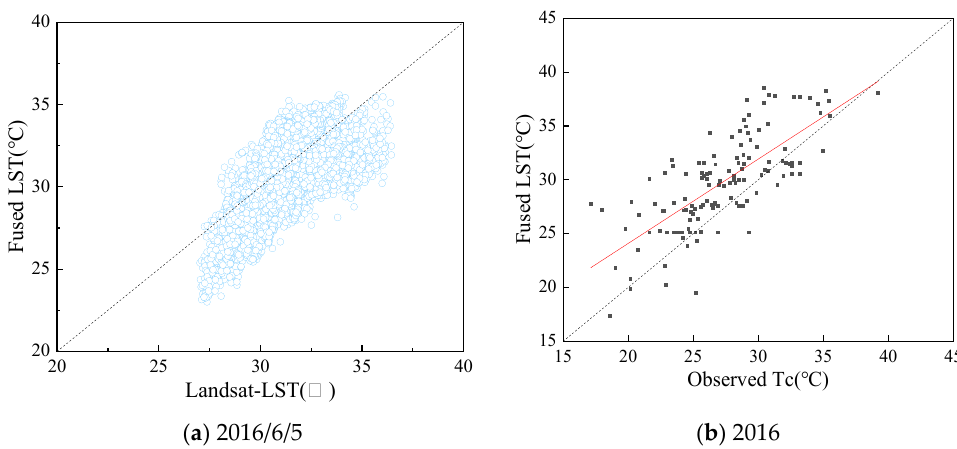
Figure 17. Regressions for accuracy evaluation of the fused LST: ( a ) the fused LST vs. the inversed values from Landsat 8; ( b ) the fused LST vs. the observed Tc in experimental station in 2016. Figure 18 shows the spatial grain yield estimates retrieved using DBA measured on four acquisition dates that include (a) 4 July, (b) 21 July, (c) 4 August, and (d) 26 August in 2016 based on the model calibrated in 2019. The predicted yield showed a significant upward trend as the acquisition date of DBA approached harvest. Meanwhile, the com- parisons between the predicted and measured yield in situ were conducted with statistical parameters as evaluation metrics of accuracy (Table 7). The predicted yields coincide with the measured ones with RE values, ranging from −16.14% to 9.84%, which confirms that assimilating once-measured data into the model can produce a great estimate of grain yield. Comparatively speaking, DBA assimilation closer to the harvest date allows for a more accurate prediction of yield except for the results based on the data on 21 July, which may be caused by the irrigation measures or the model parameters. Assimilating DBA measured on 4 July also provides a reliable result, albeit with a slightly lower R 2 . Such a result proves the feasibility of the approach for early yield forecasting in other large areas though the optimal date of sampling still needs to be explored and determined further.